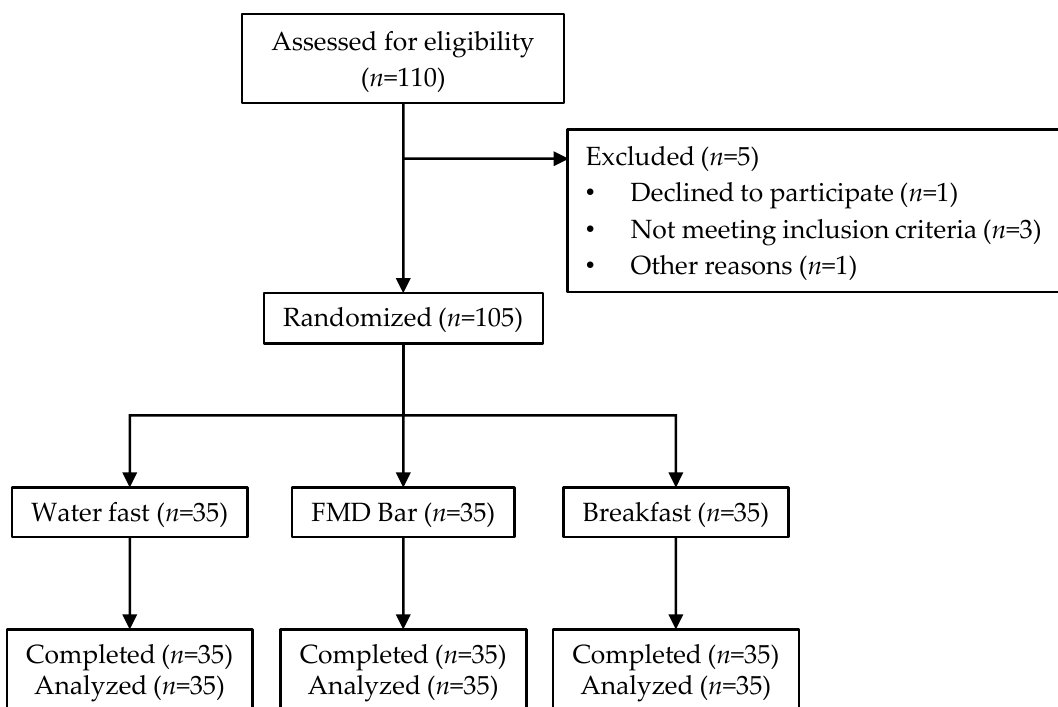
Figure 1. CONSORT diagram of 105 subjects participating in the FMD (fasting-mimicking diet) bar study (July to September 2020). Table 2. Baseline sample characteristics. Continuous variables are described using mean ± standard deviation, while cat- egorical variables are described with count (frequency).